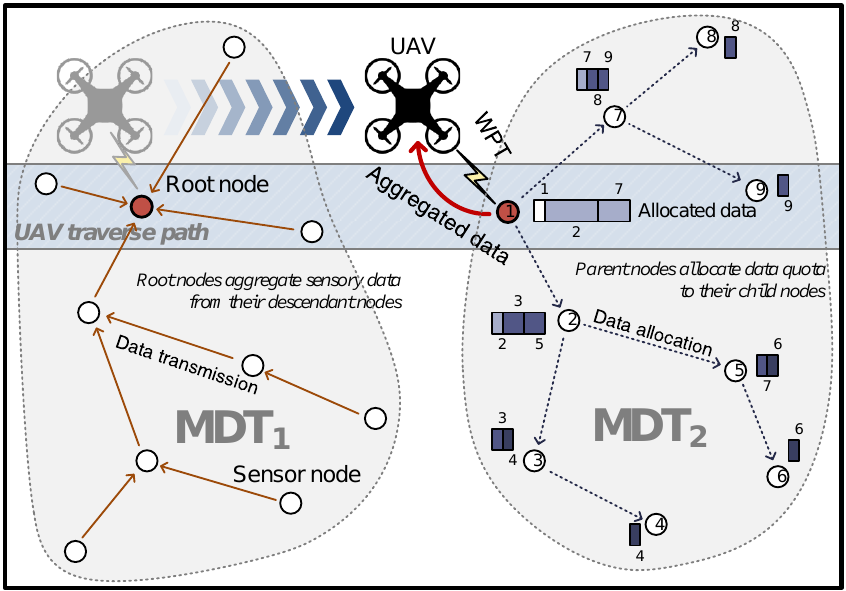
Figure 1. Overview of the proposed